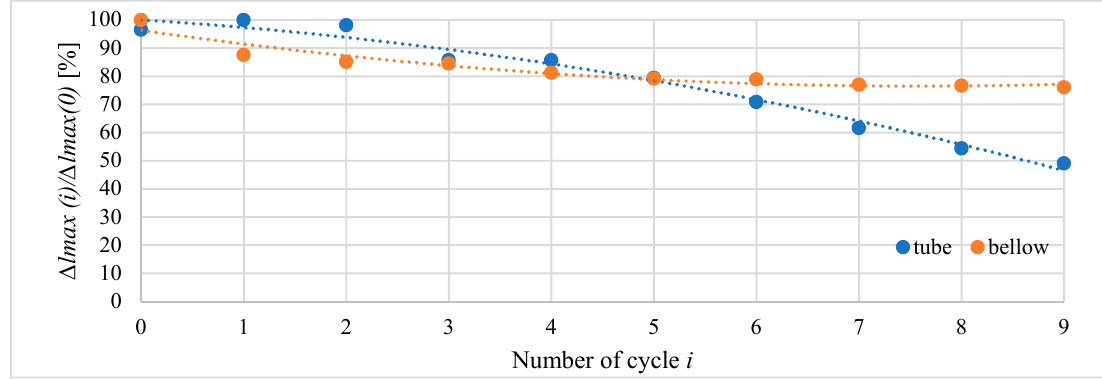
Figure 18. The first cycle number 0 started at room temperature. The next started at 50 °C.